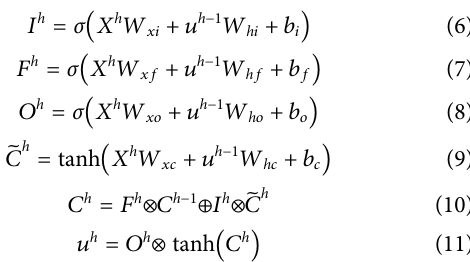
Figure 4 . The multidimension load feature X h of time slot h is input